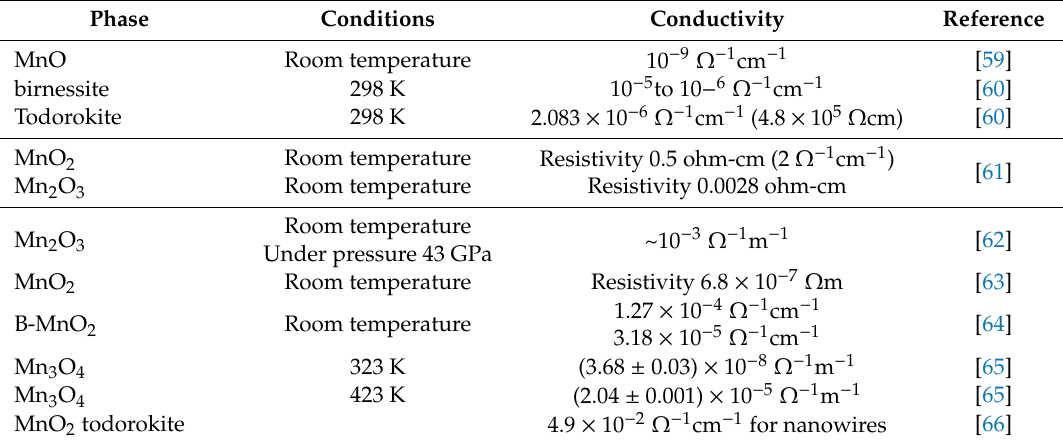
Table 3. Conductivity values for di ff erent manganese